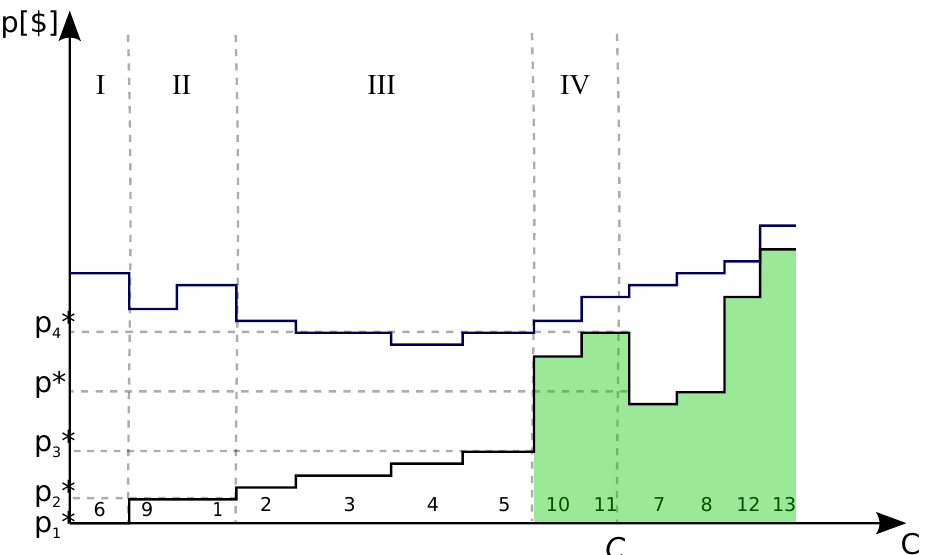
Figure 5. Merit order of capacity (lower graph) and respective adjusted price markup (upper graph) of the successful power plants identifiable by the respective number n = 1, . . . ,13 ordered by increasing price bids within each of the four groups (step